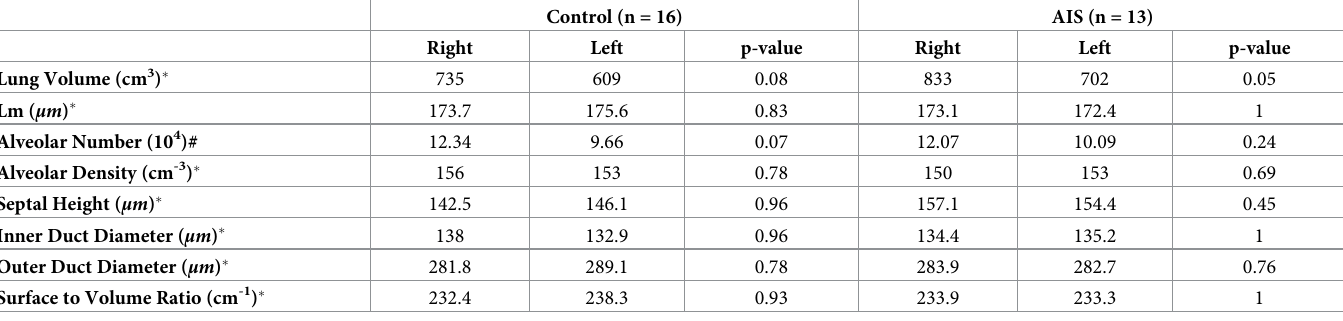
Table 3. Right vs left lung comparisons in AIS vs. control.